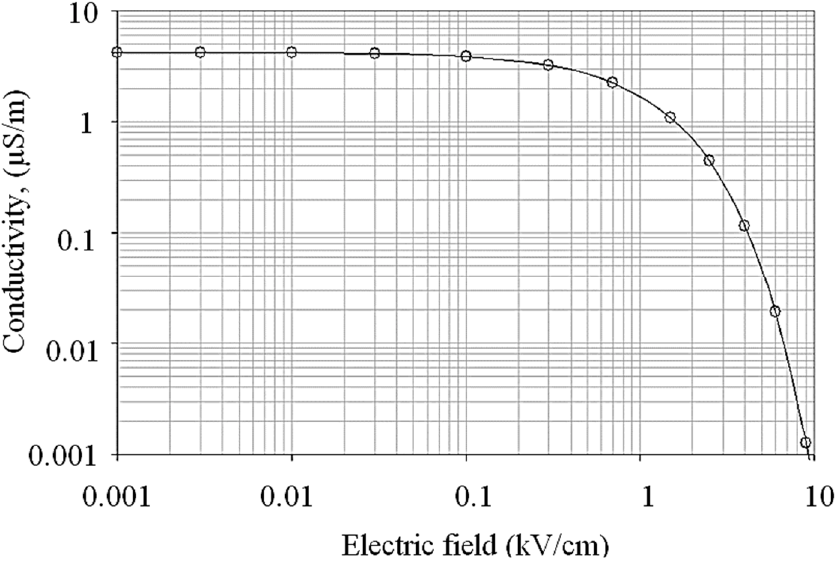
Figure 12. Field-conductivity relationship for the pollution model under fog weather conditions (i.e., uniform wetting action).